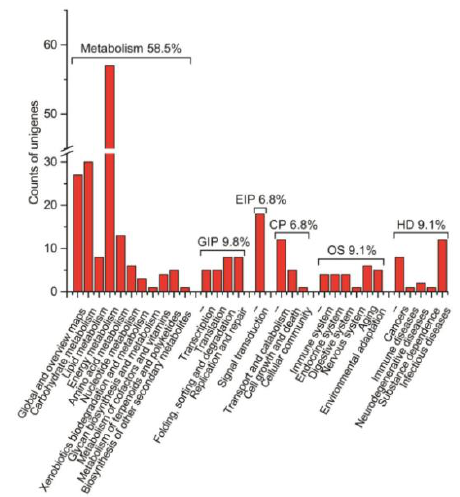
Figure 10. Functional annotation and classification of 804 Triticum aestivum annotated UniESTs using the BLAST2GO software. The three GO categories, cellular component ( A ), molecular function ( B ), and biological process ( C ), are presented.